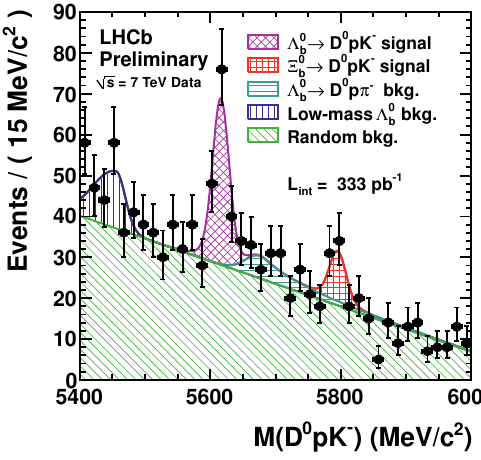
Figure 9. Invariant mass distribution of the selected D 0 pK − combinations. 0 . 5 s y st . The Ξ 0 mass measurement performed at LHCb of 5802 . 0 ± 5 . 5 stat ± 1 . 7 s y st is b